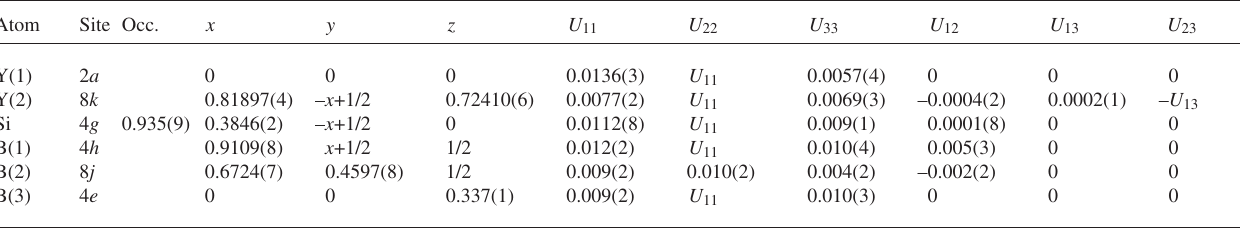
Table 2. Atomic coordinates and displacement parameters (in Å 2 ) .